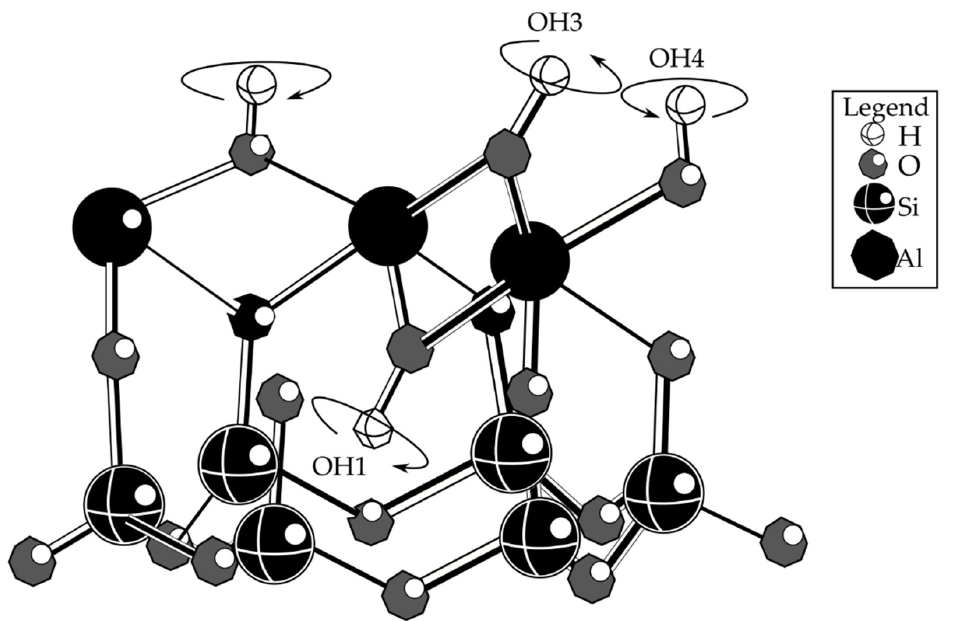
Figure 5. Chemical structure of kaolin [95]. Kaolin is a common mineral found in soils and sediments, and it has a wide range of applications. This clay mineral is a 1:1 layer aluminosilicate in which an alumina octahedral sheet and a silica tetrahedral sheet are fused to produce a layer held together by hydrogen bonding [73,93,96]. This clay possesses no exchangeable cations [89,97,98], because isomorphic substitution and cationic vacancies are near to